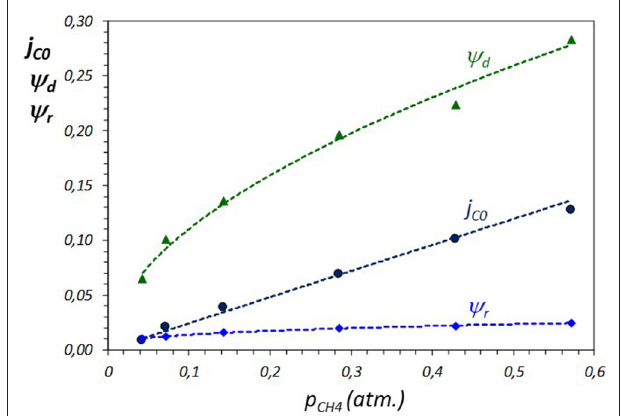
FIGURE 10 | Influence of CH 4 concentration on the kinetic parameters.